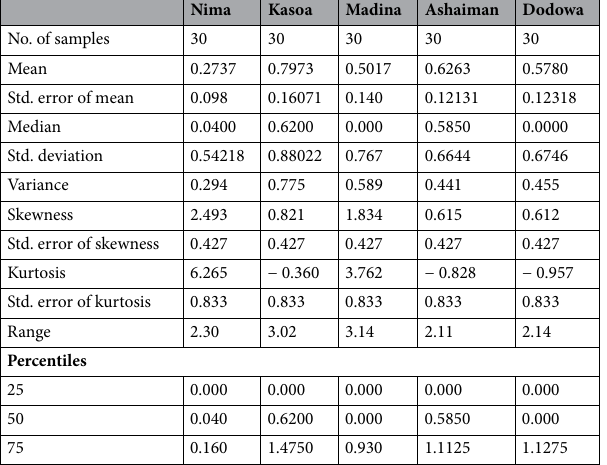
Table 2. Summary of statistics of AFM 1 in fermented milk beverage brukina obtained from five different areas of Greater Accra region, Ghana.